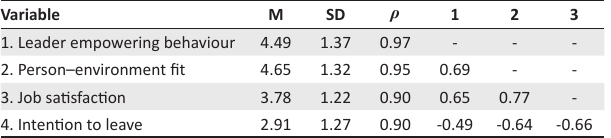
TABLE 2: Descriptive statistics, Raykov’s rho values and correlation